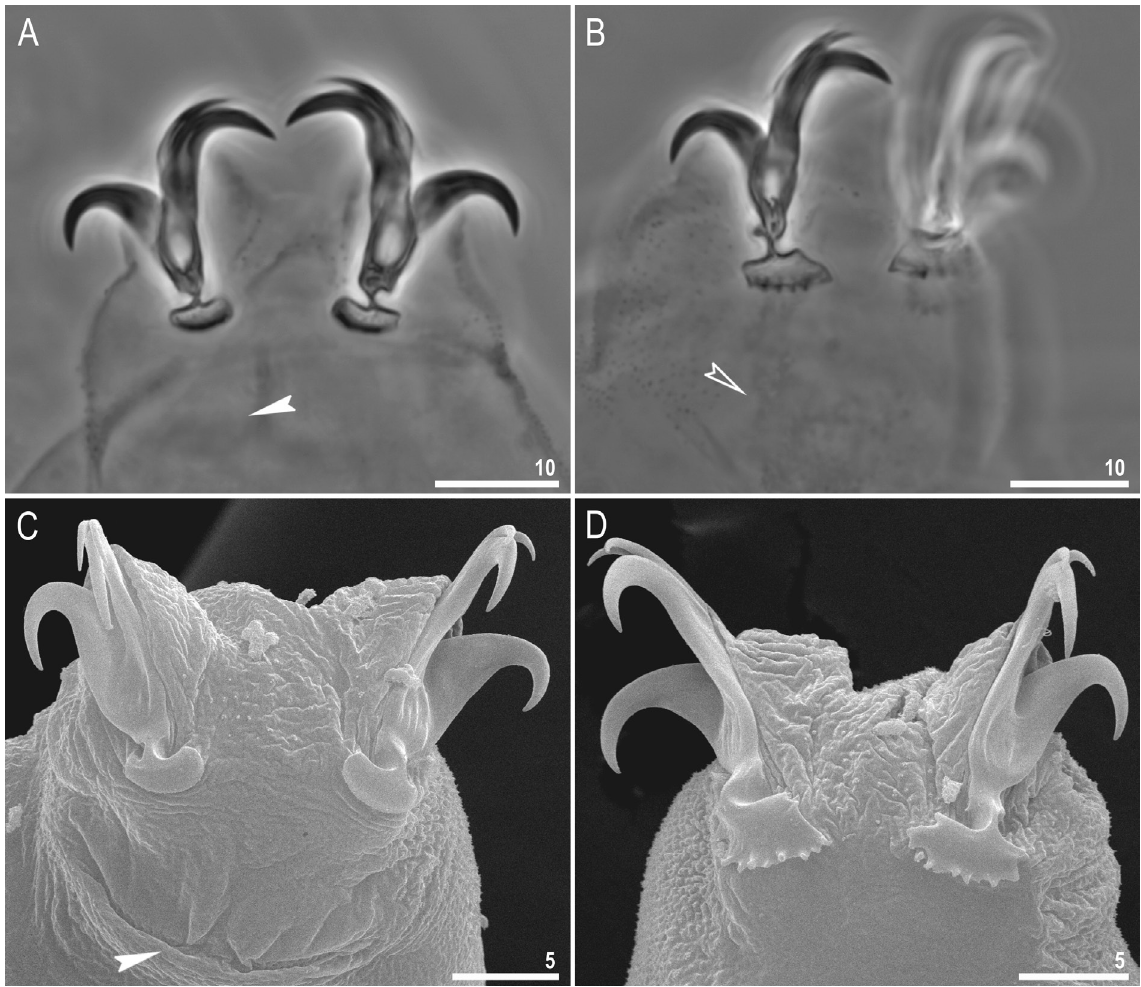
Fig. 11. Macrobiotus kamilae sp. nov., claws. A–B . Claws III and IV seen in PCM, with smooth and dentate lunules, respectively (holotype, IZiBB IN.030.08). C–D . Claws III and IV seen in SEM, with smooth and dentate lunules, respectively (paratype, IZiBB). Filled indented arrowheads indicate double muscle attachments under the claws whereas empty indented arrowhead indicates the horseshoe structure connecting the anterior and the posterior claw. Scale bars in